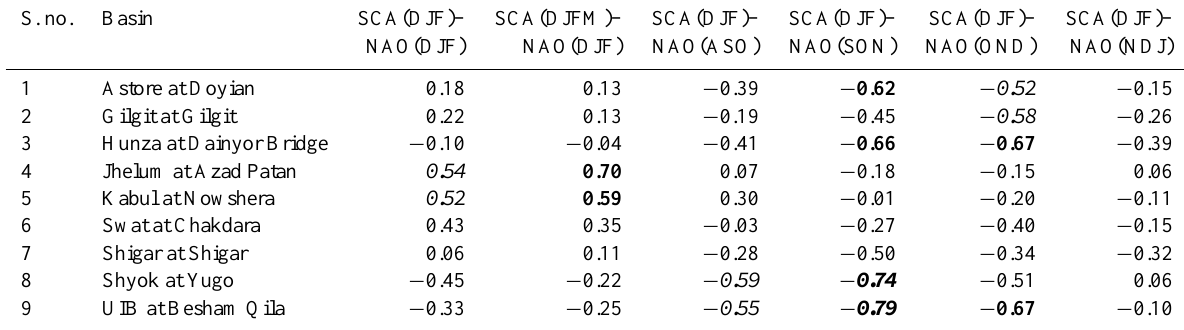
Table 9. Correlations between the NAO index and the snow cover (SC) of the studied basins. Correlations significant at the 90% level are marked in italic only, at the 95% level are marked in bold only, and at the 99% level are marked in bold and italic. S. no.